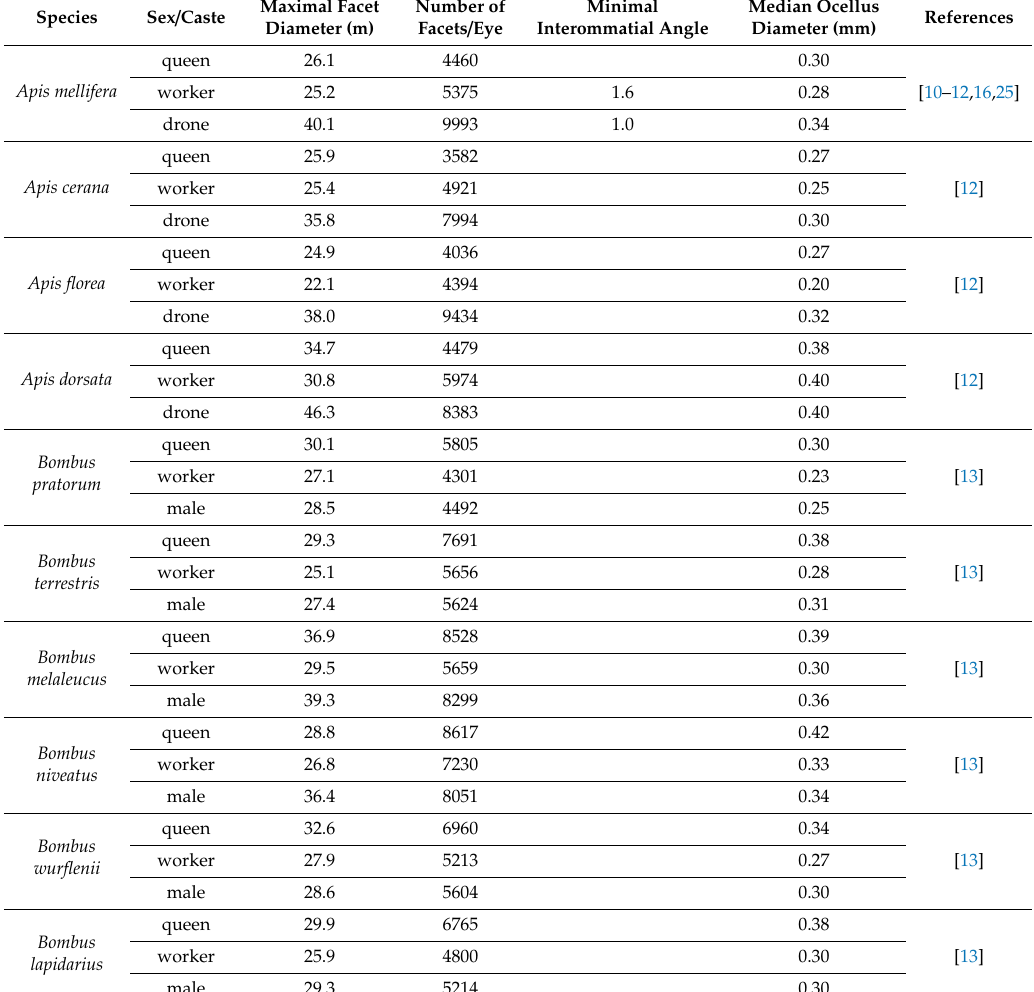
Table 2. Sexually dimorphic eyes and ocelli are common amongst Apidae. For additional details please see the